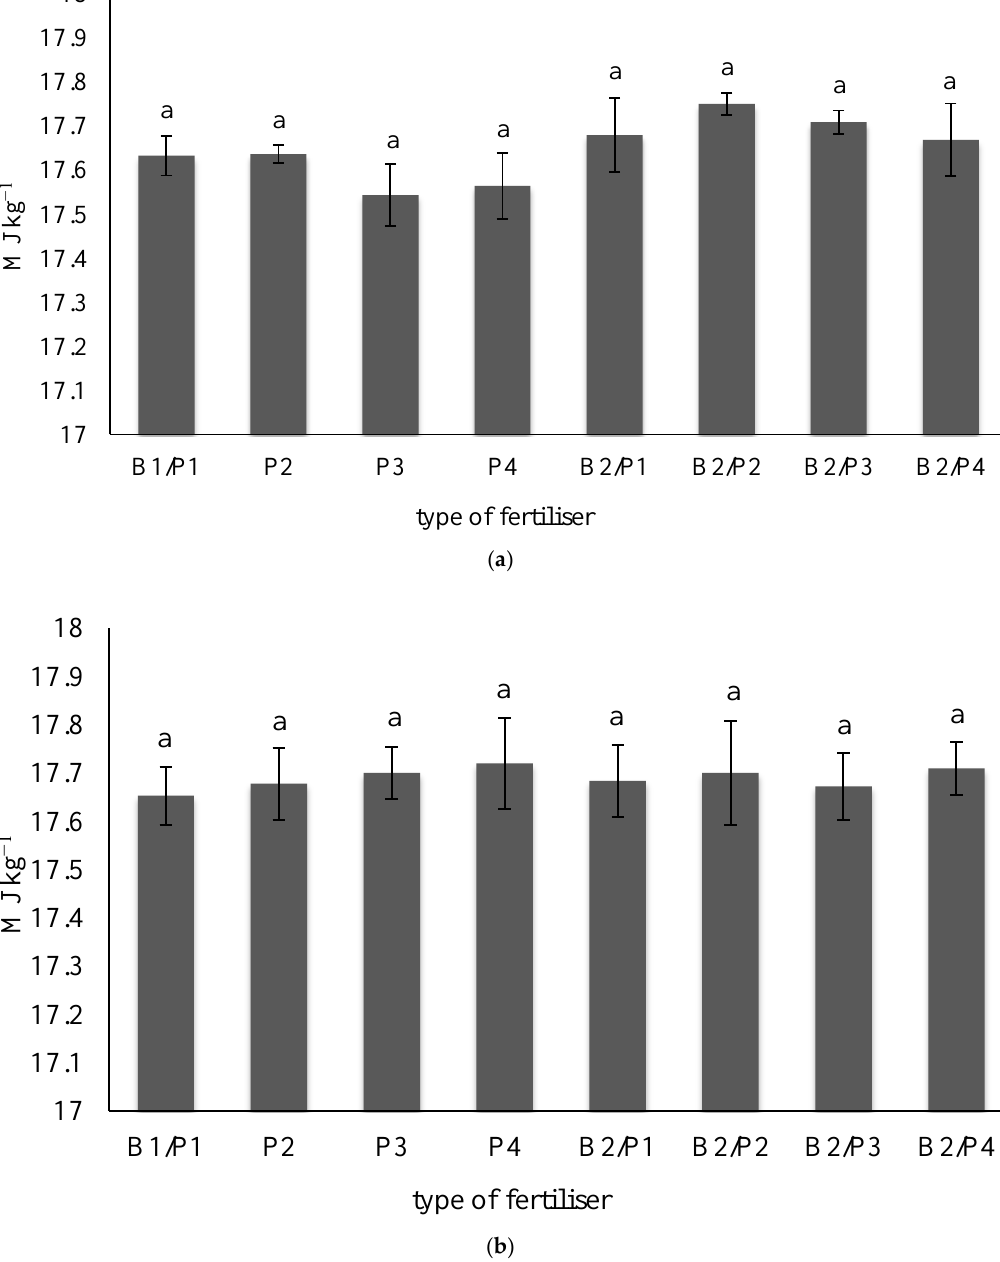
Figure 6. Calorific value of giant miscanthus after the first ( a ) and second ( b ) year of cultivation, depending on the fertiliser used. Differences between average values marked with the same Arabic letters are not statistically significant at the level of α ≤ 0.05 according to the Bonferroni test.